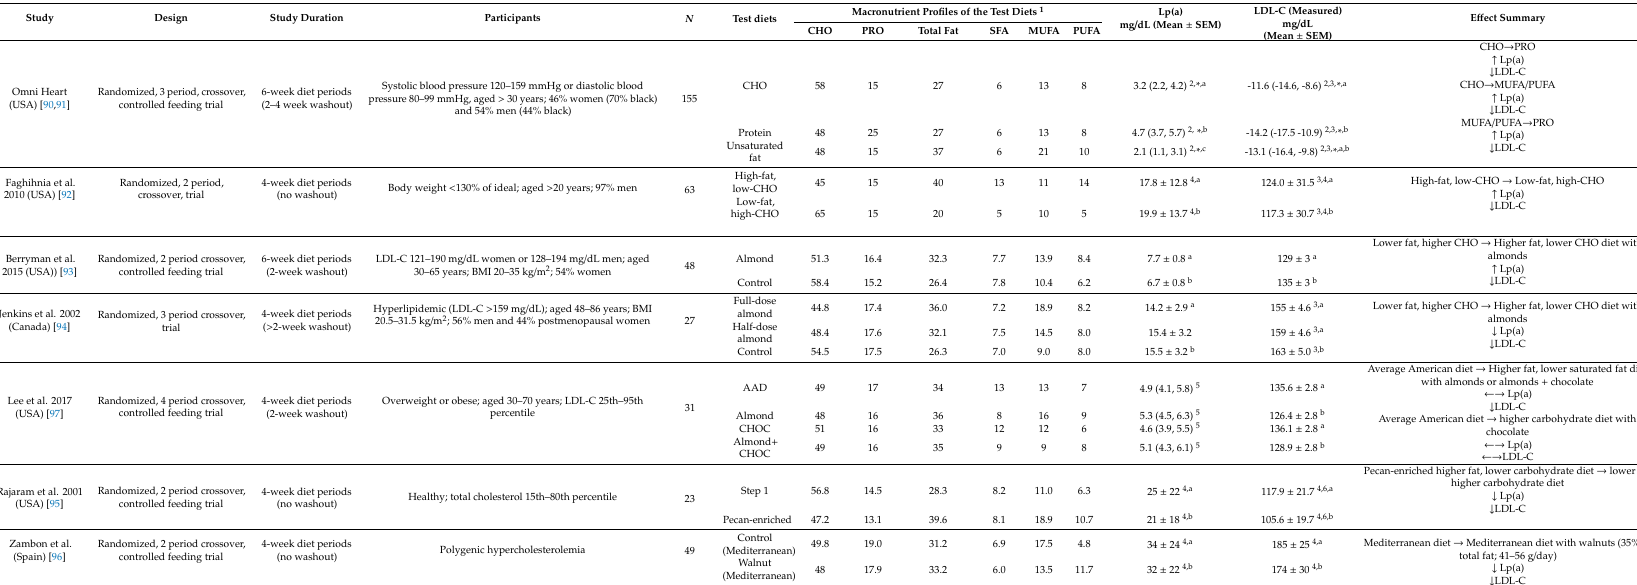
Table 2. The e ff ect of diets with di ff ering macronutrient compositions of Lp(a) and